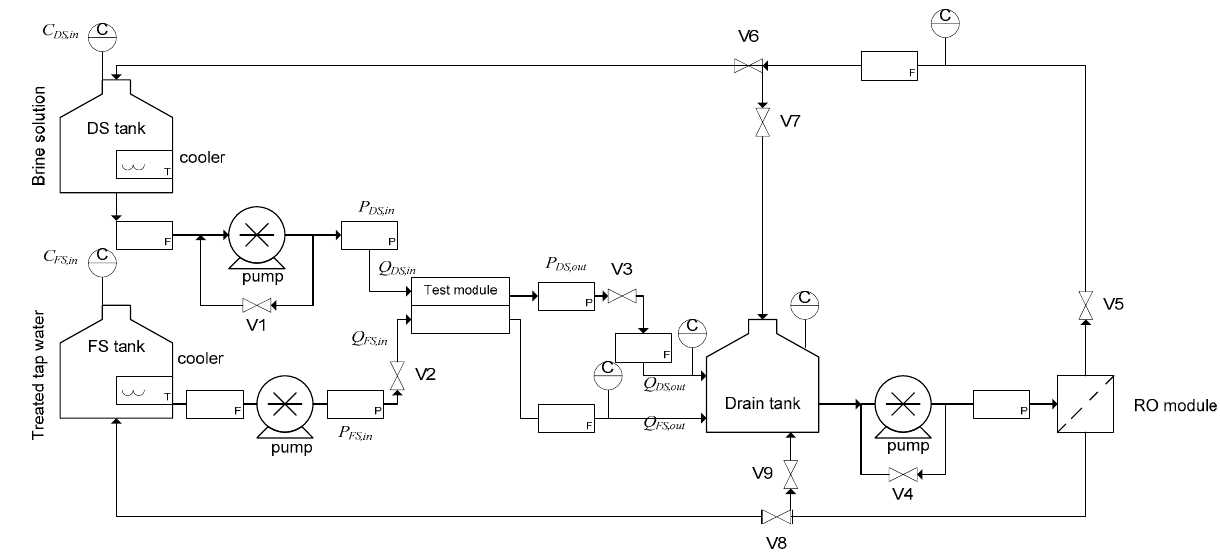
Figure 2. Schematic of the pilot-scale PRO evaluation system used in this study. C represents conductivity meter, F is flow meter, V is valve, and P is the pressure gauge.